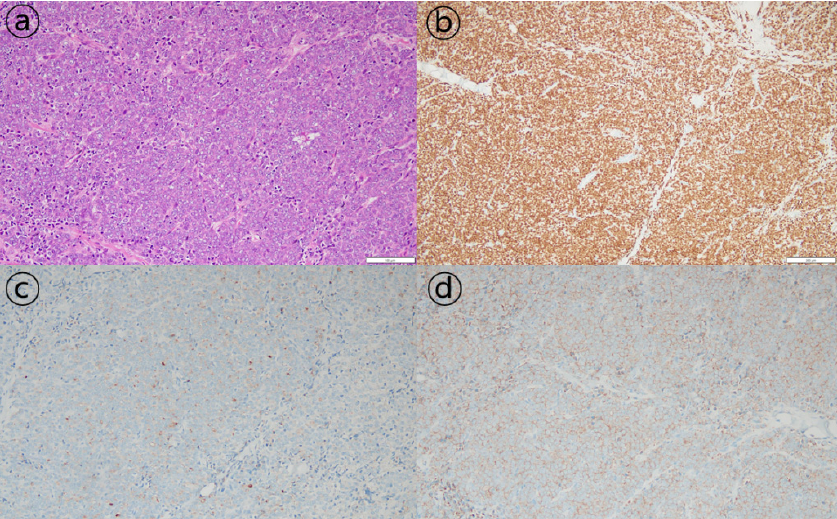
Figure 2. Histopathological findings of peritoneal carcinomatosis of prostate cancer. ( a ) Hematoxylin-eosin staining of the peritoneal nodule at a magnification of 200×. ( b – d ) Results of immunohistochemistry revealing the tumor was androgen-receptor-positive (magnification 100×), prostate-specific-antigen-positive, and alpha-methylacyl-CoA-racemase-positive (magnification 200×).